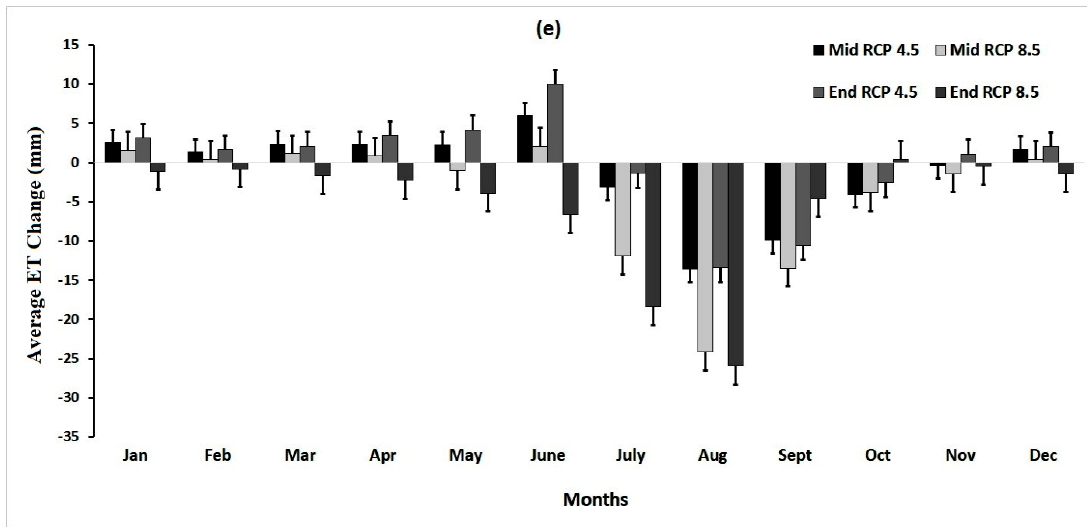
Figure 6. Average monthly change under RCP 4.5 and 8.5 for mid-century (2046–2065) and end-century (2081–2099) from the baseline period (1993-2018) for water balance: ( a ) Precipitation; ( b ) Surface flow; ( c ) Lateral flow; ( d ) Water yield; and ( e ) Evapotranspiration (ET) in the Osan Watershed.